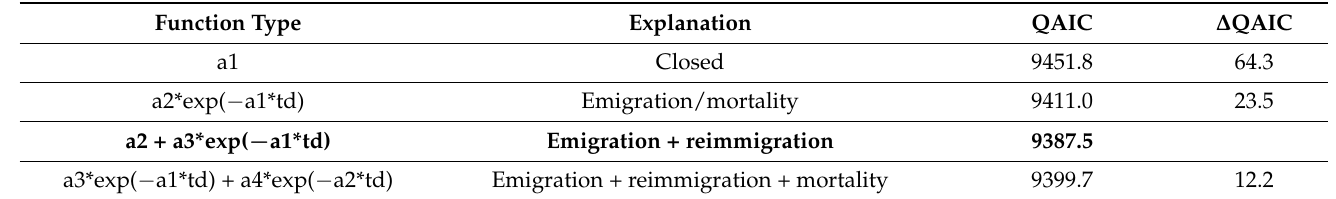
Table 3. Models fitted to LIR data from the Gulf of Taranto. The model that best fit the data according to QAIC is shown in bold. ∆ QAIC indicates how well the data support the less favored model (Burham and Anderson